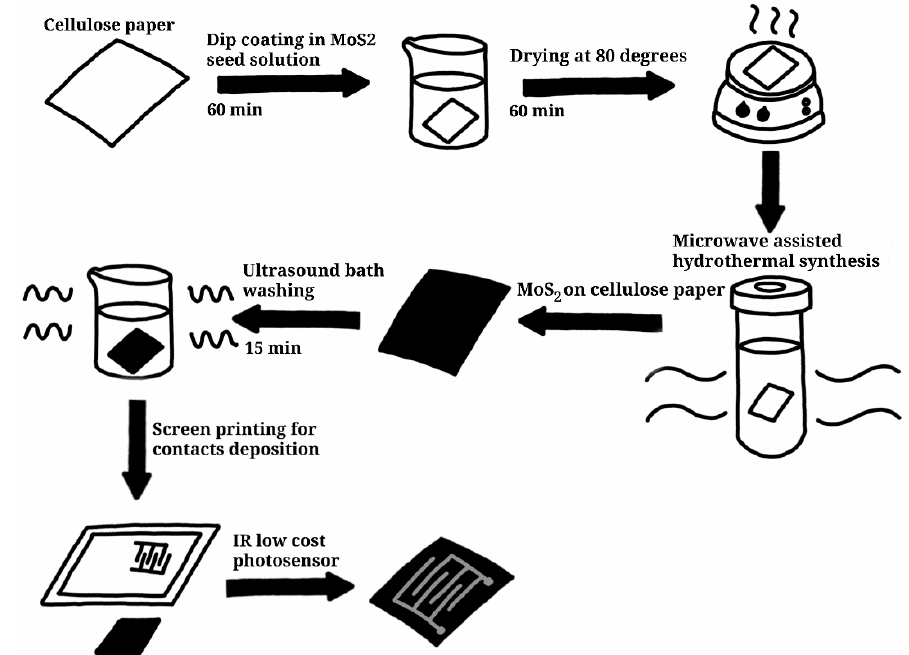
Figure 1. Scheme of the synthesis process of the molybdenum disulfide (MoS 2 ) nanostructures in paper substrates by the microwave ‐ assisted hydrothermal method, and the production of infrared radiation photodetectors.